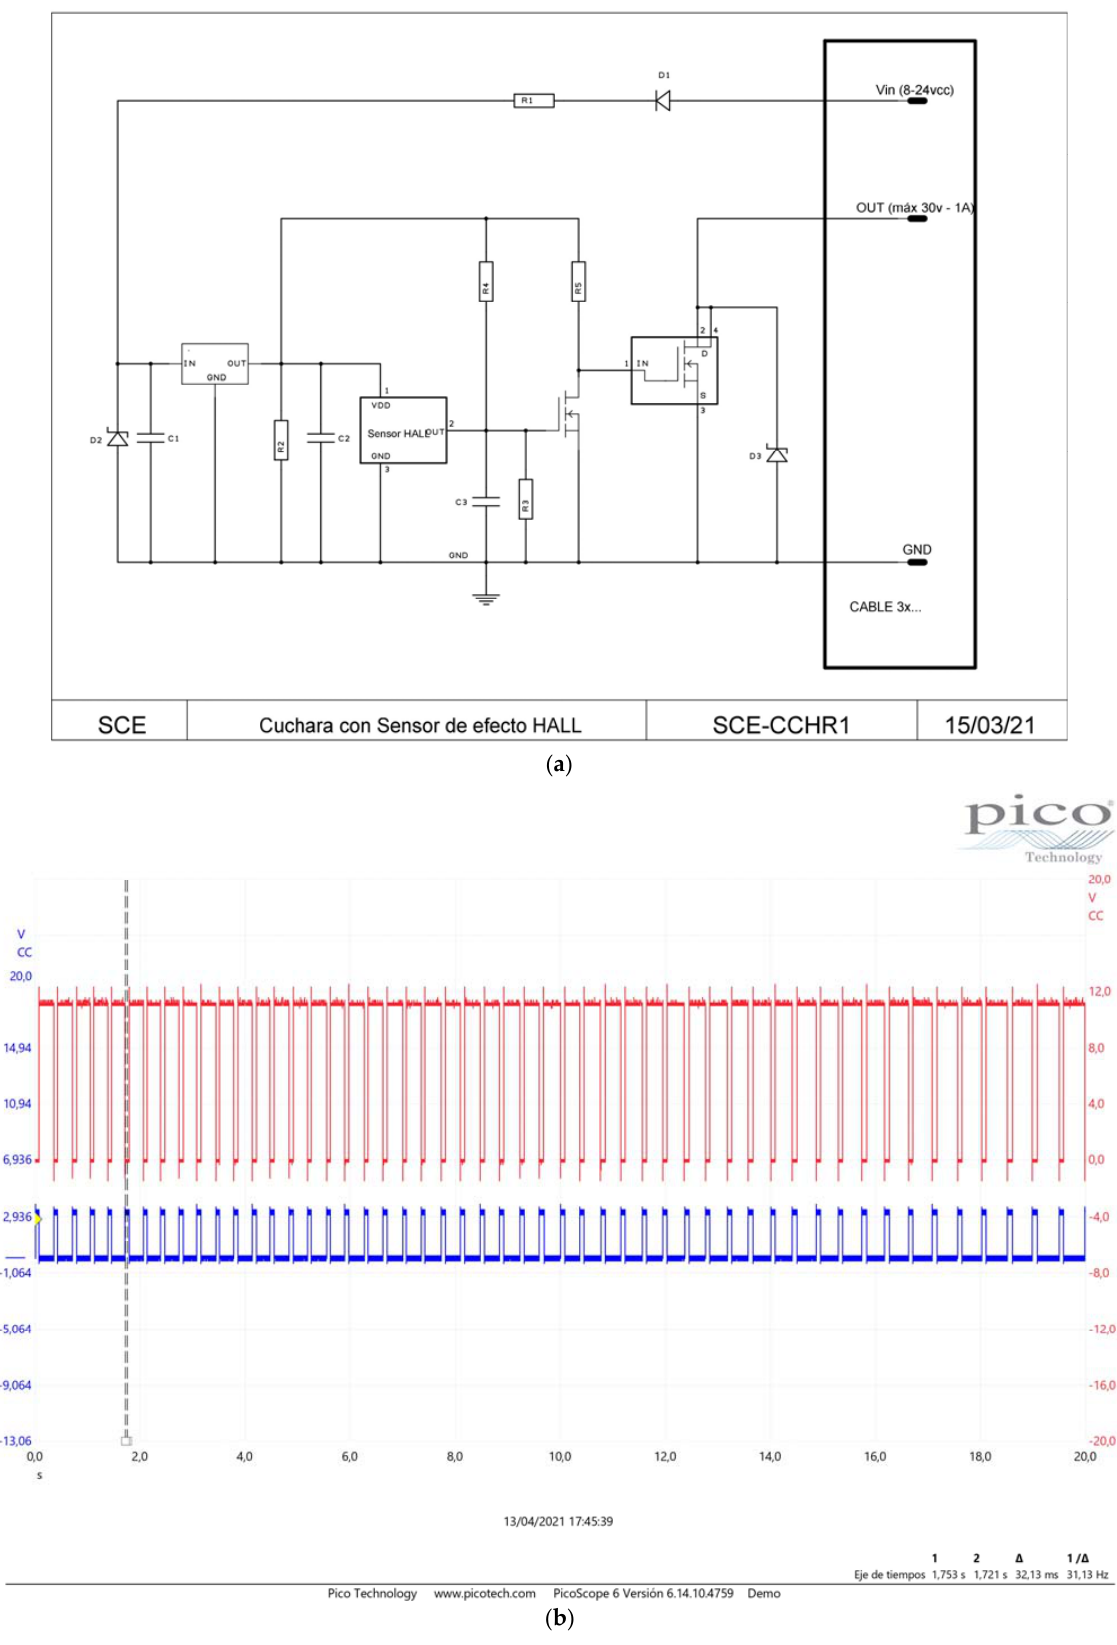
Figure 10. ( a ) Screenshot of diagram of double bucket meter with Hall effect sensor SCE-CCHR1. ( b ) Signal obtained by the most sensitive Hall effect sensor.